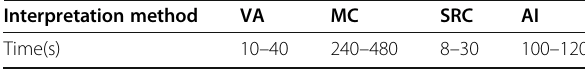
Table 1 Time required for interpretation of each Ki-67LI Interpretation